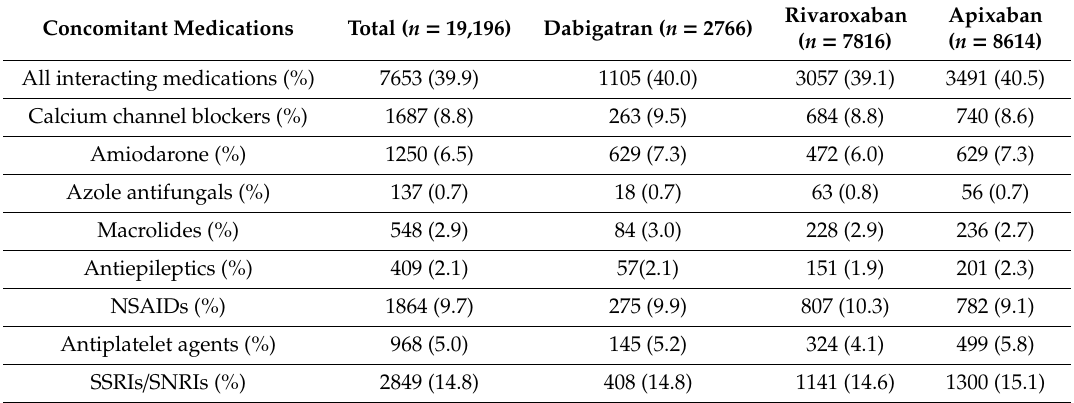
Table 1. Concomitant medications prescribed with direct-acting oral anticoagulants in 2018. Concomitant